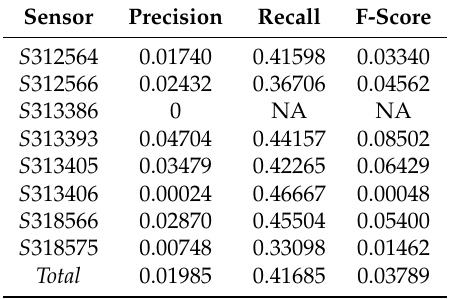
Table 16. The quality of fit for the Phase 2-Test data based on the thresholds determined by the Phase 2-Train